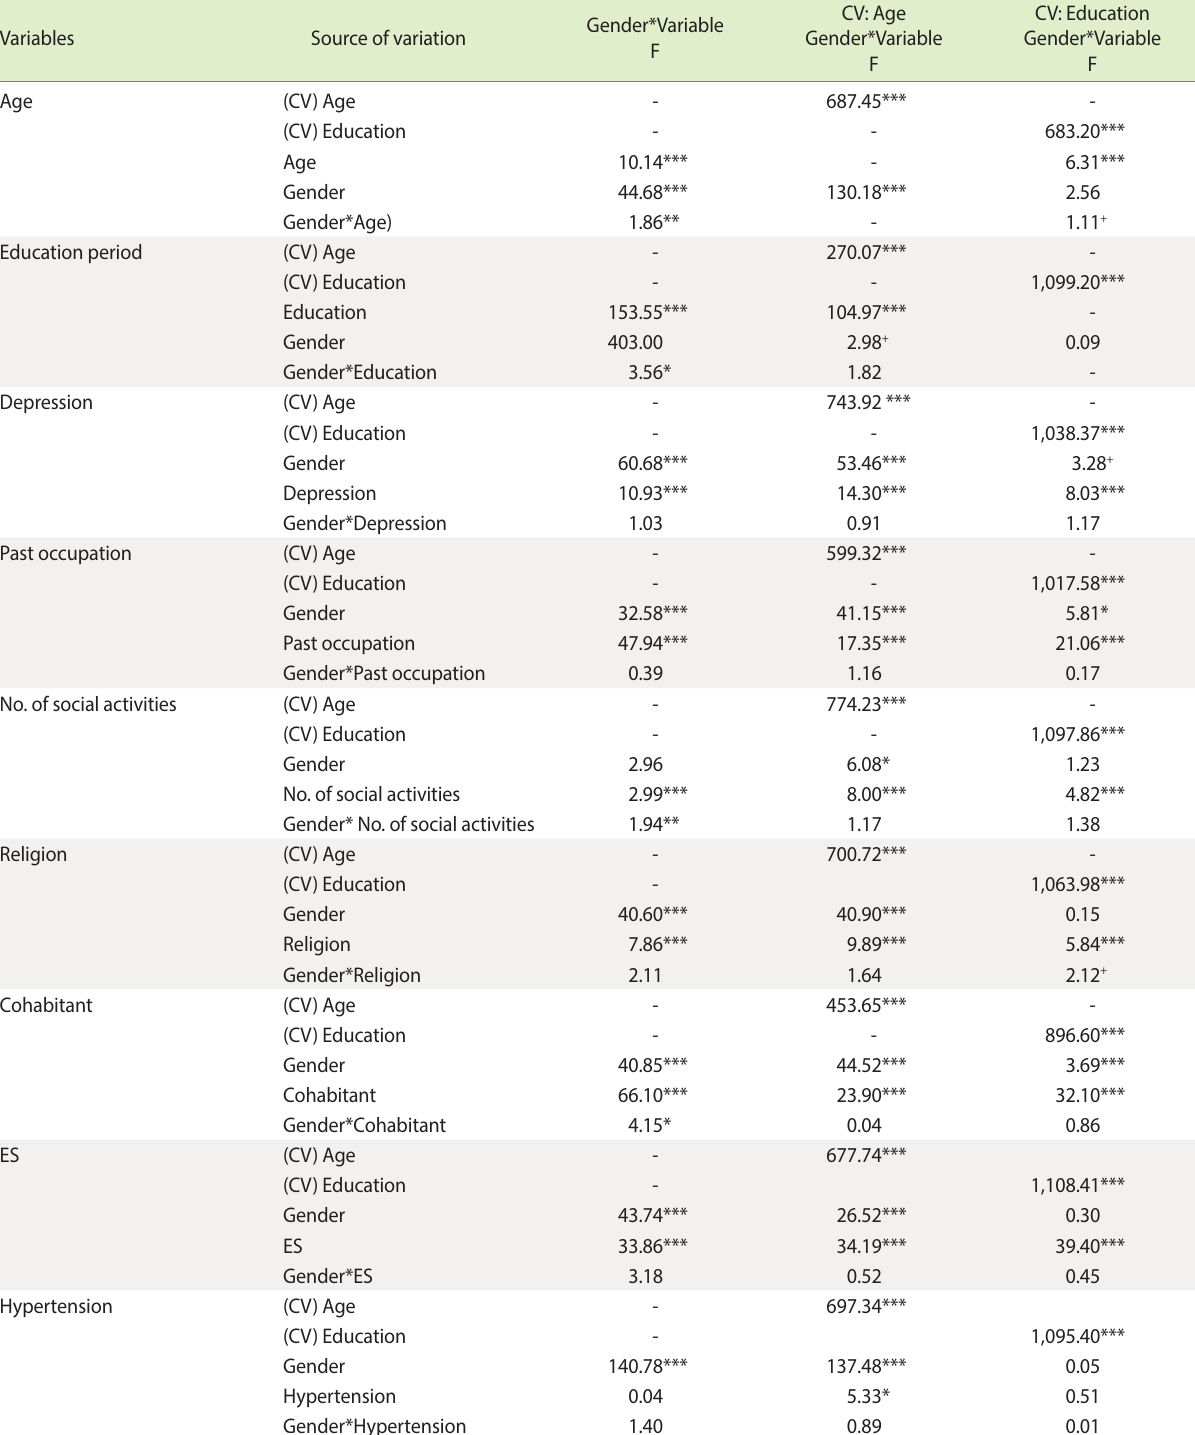
Table 3. Gender interaction in the effect of variables on cognitive function